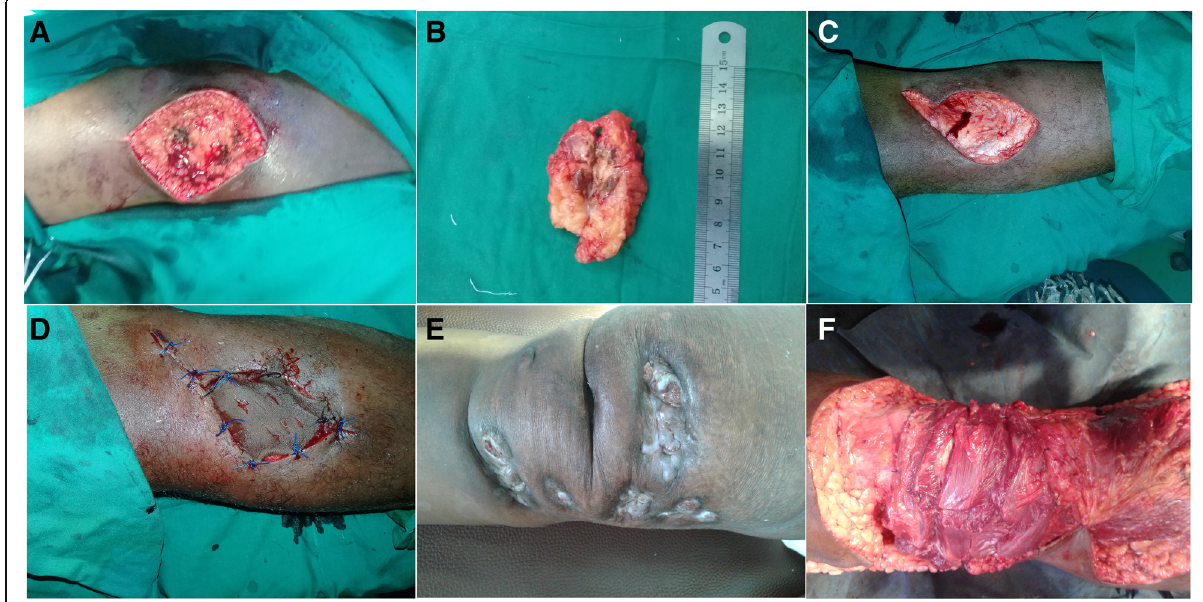
Fig. 1 Wide surgical excision (WSE) and primary closure, skin graft, or flap. a WSE with a margin of mycetoma lesion. b The excised same lesion which measures about 6 cm. c , d WSE with margin defect closed with skin graft. e Recurrent knee mycetoma. f Reconstruction after excision with gastrocnemius